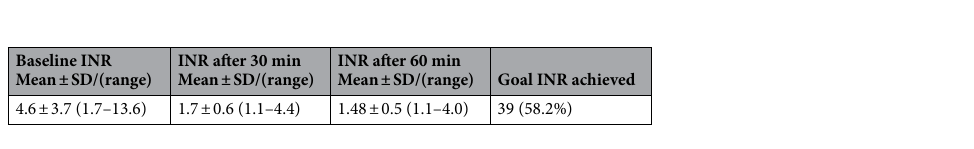
Table 3. Mean INR values before and after receiving aPCC.